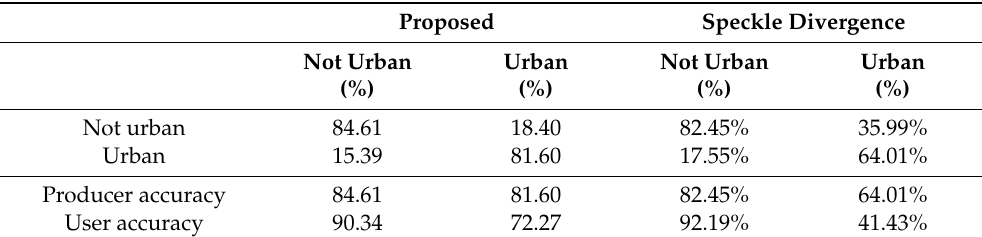
Table 2. Dresden: confusion matrix for the urban/not urban classification using reference data de- rived from the Urban Atlas. Proposed methodology—overall accuracy: 83.61%, kappa coefficient: 0.64. Urban density windows ~150 m and ~450 m. Speckle divergence—overall accuracy: 79.45%, kappa coefficient: 0.38. Threshold set to 0.6.